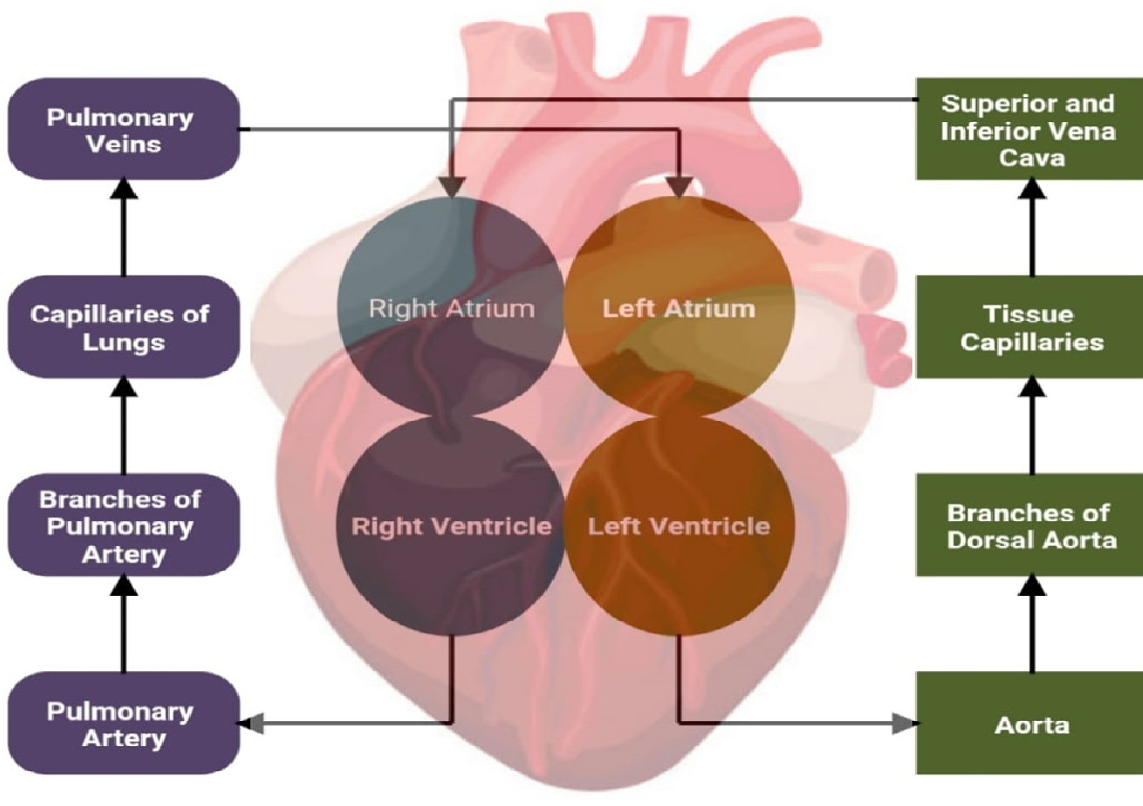
Figure 1. Schematic diagram of heart.